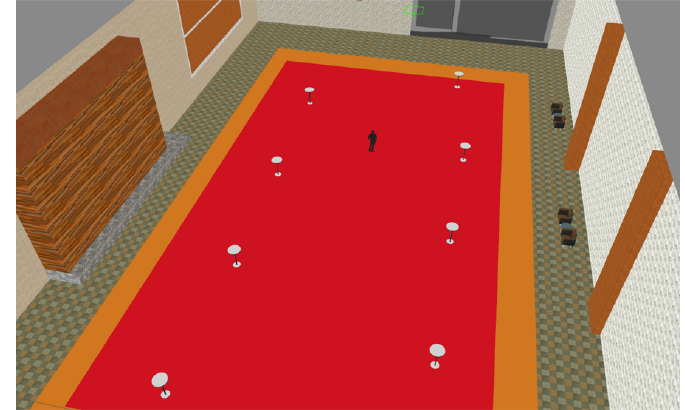
Figure 4. Simulation environment without any virtual agents